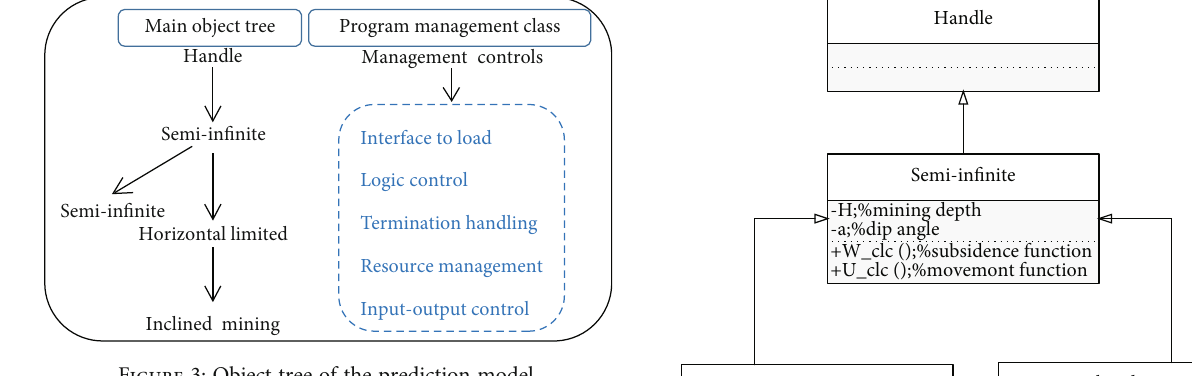
Figure 3: Object tree of the prediction